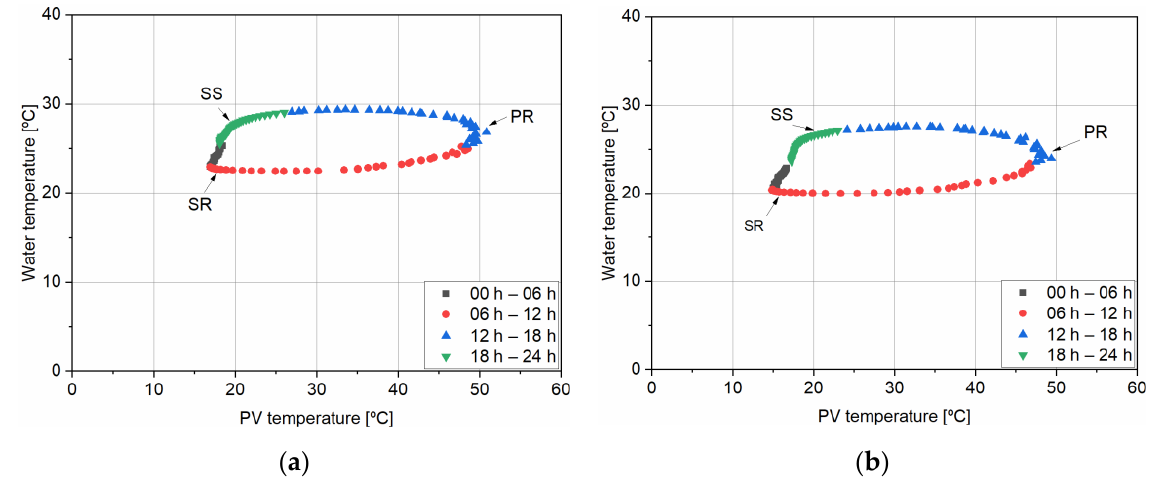
Figure 12. BIPV-WS water thermal behavior: ( a ) August 22nd, non-ventilated air cavity; ( b ) August 30th, ventilated